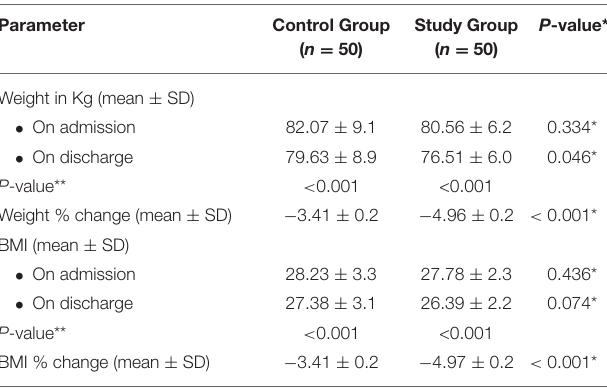
TABLE 3 | Change in the BMI of the studied